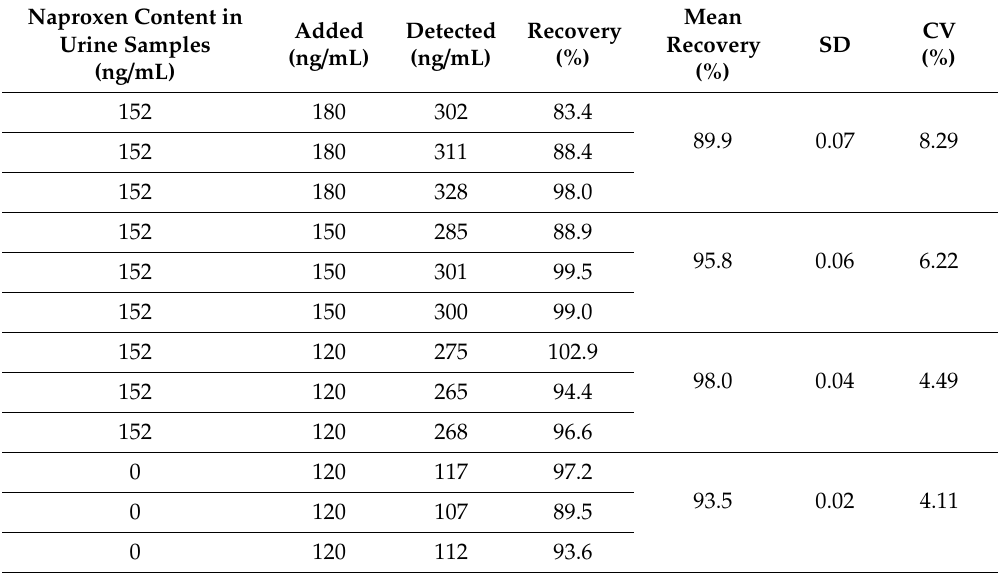
Table 1. Results of the recovery evaluation at three spike amount levels with treated and untreated urine samples.